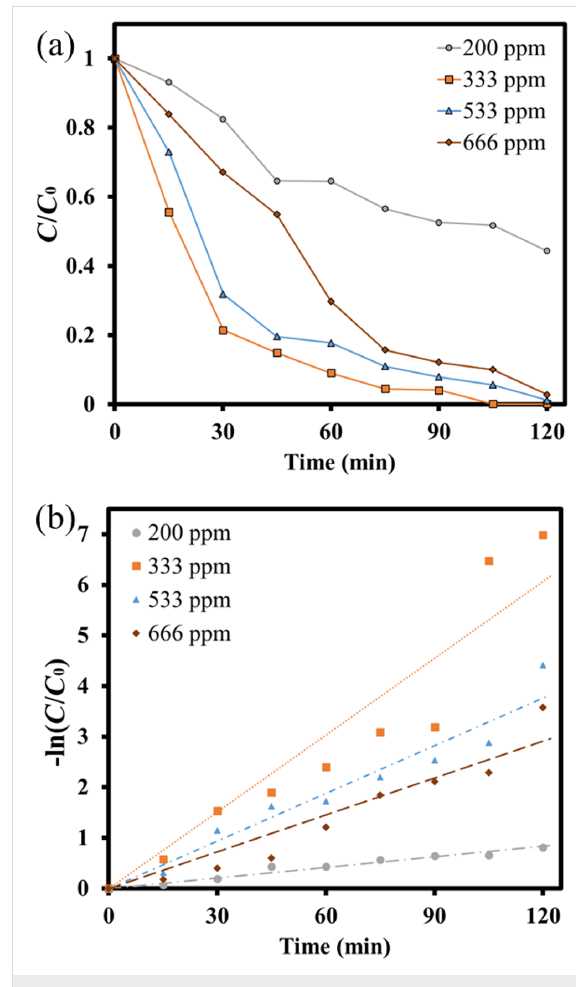
Figure 11: (a) The C / C 0 and (b) 1st order kinetic analysis of the MB photodegradation using LaFe 0.7 Ni 0.3 O 3 operating at different catalyst